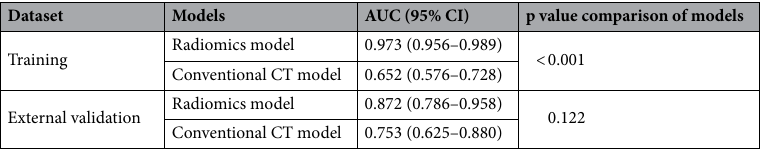
Table 5. Discrimination performance of radiomics and conventional CT models in training and validation datasets.